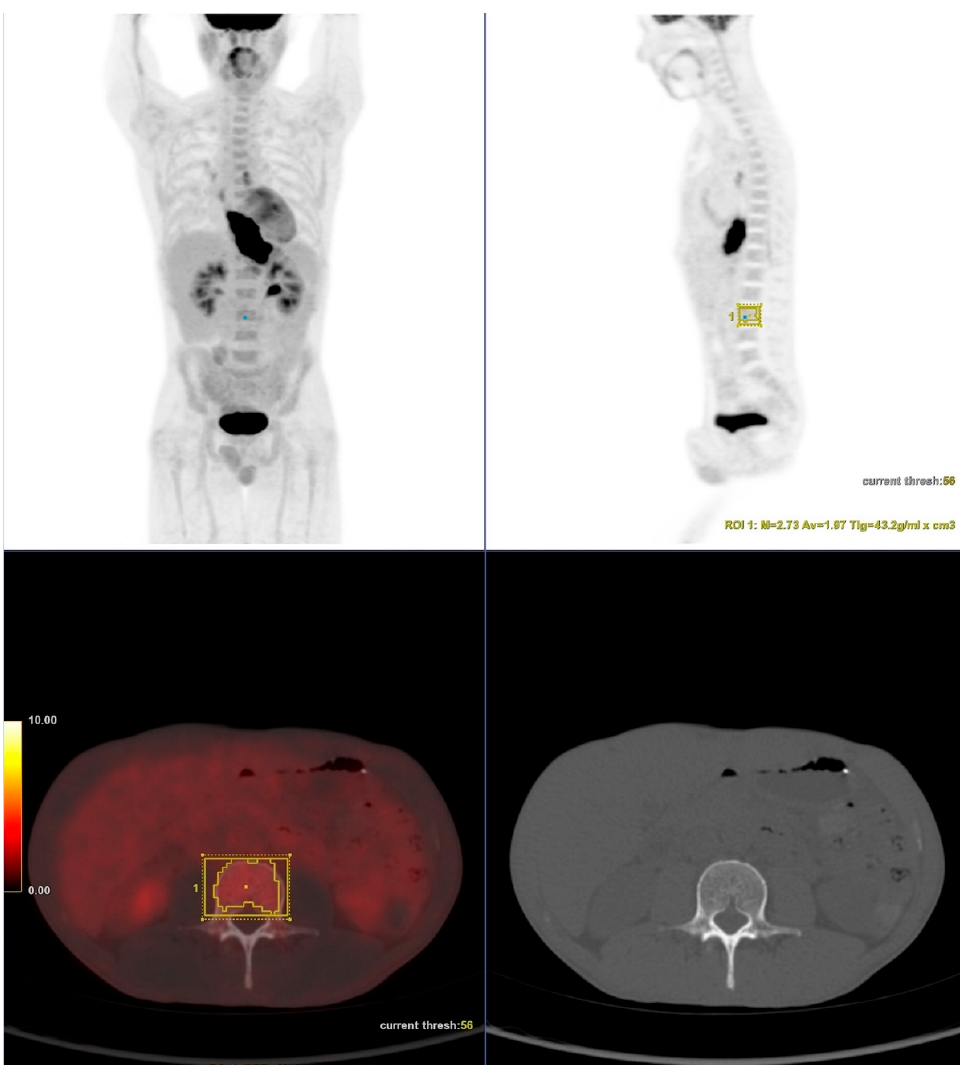
Figure 1. 18F-FDG PET/CT showing a patient with esophageal cancer. Volumes of interest (VOIs) were drawn over in one of the L3-L5 vertebral bodies, preferably L3. Care was taken to exclude bones with fractures, as shown in CT slice. Automatic isocontour was generated, and the mean SUV was calculated.